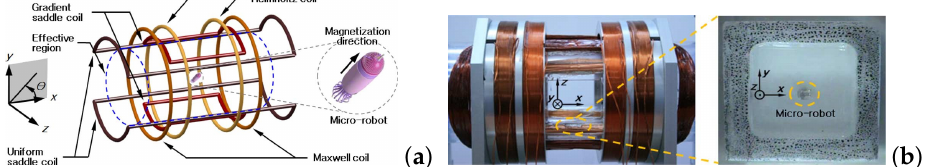
Figure 10. HMUG EMA platform developed by Jeon et al. [62]: ( a ) scheme of the concept; and ( b ) a photograph of the built system.